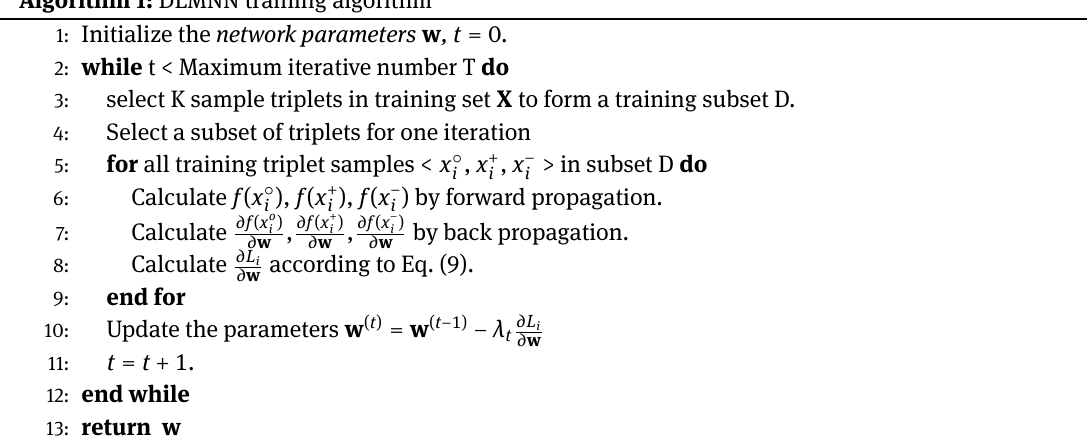
Algorithm 1: DLMNN training